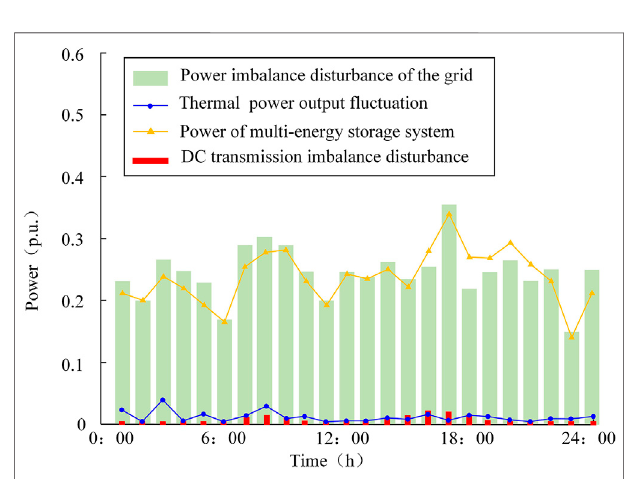
FIGURE 9 | Grid power adjustment curve of the power grid with proposed dynamic partition control.